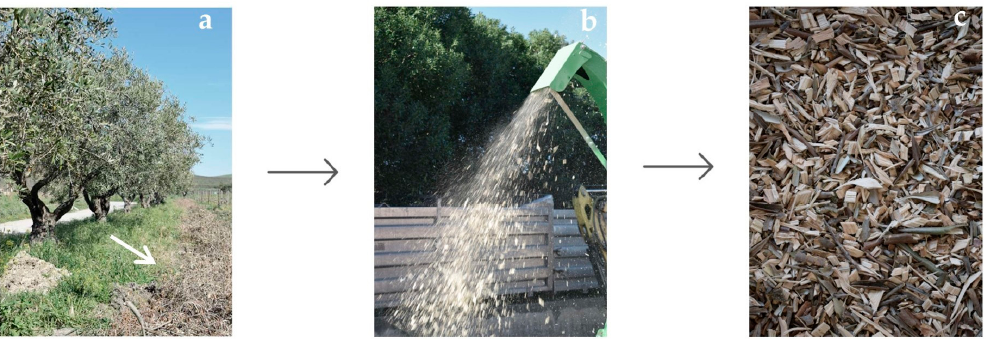
Figure 1. Sequence adopted to obtain the by-product from olive tree pruning: ( a ) pruning product (from pruning waste left on the fields); ( b ) pruning chipping; ( c ) obtained by-product. Table 1. Characteristics of the basic